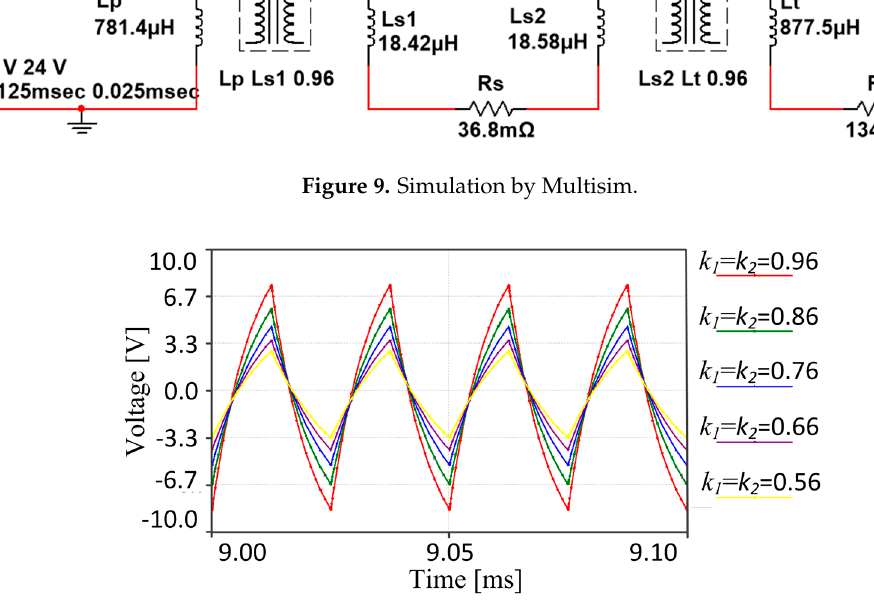
Figure 10. Simulation of voltage waveforms of the load (comparison of the coupling factors).